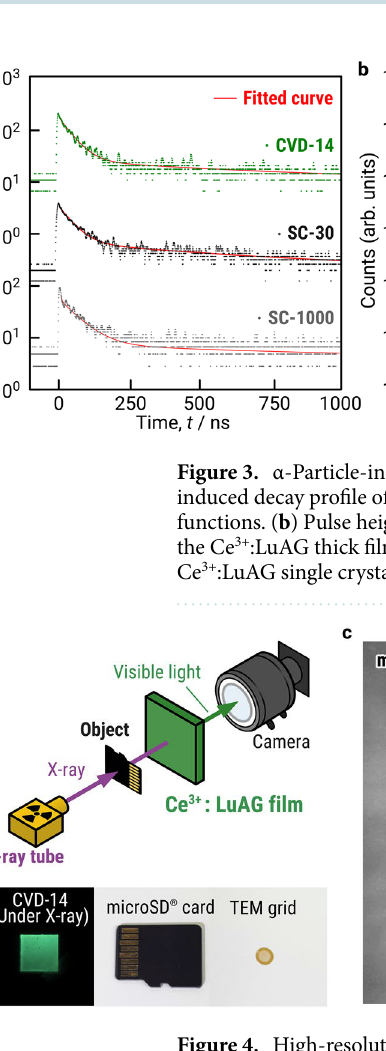
Figure 4. High-resolution X-ray imaging test. ( a ) A schematic of high-resolution X-ray imaging test using CVD-14. ( b ) Photograph of CVD-14 under X-ray irradiation as a scintillation screen (left), and radiographic subjects of microSD card (center) and TEM grid (right) under room light. ( c ) X-ray radiograph of microSD card. ( d ) X-ray radiograph of TEM grid. Solid line depicts a schematic of hexagonal mesh made with 5 μm-width bar. ( e ) Line intensity profile along the dashed line in the radiograph ( d